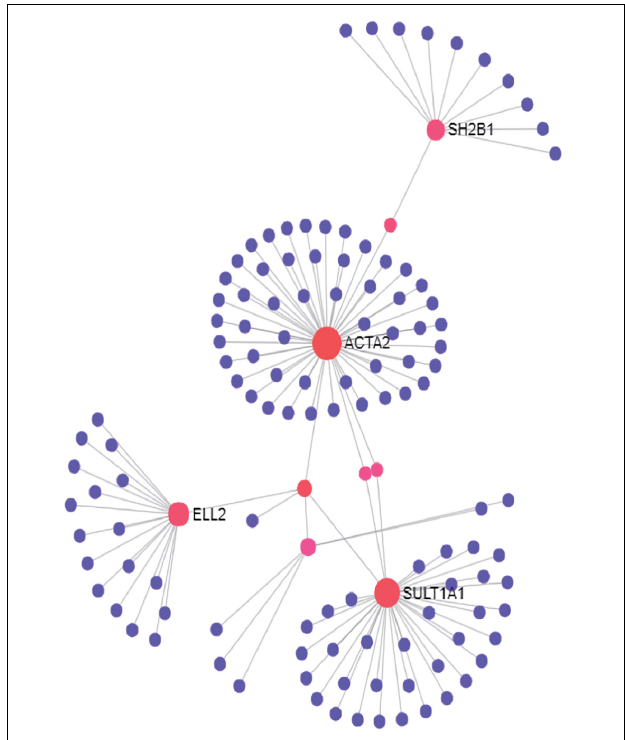
FIGURE 1 | PPI network of first-order interactions constructed for JIA loci target genes in neutrophils.